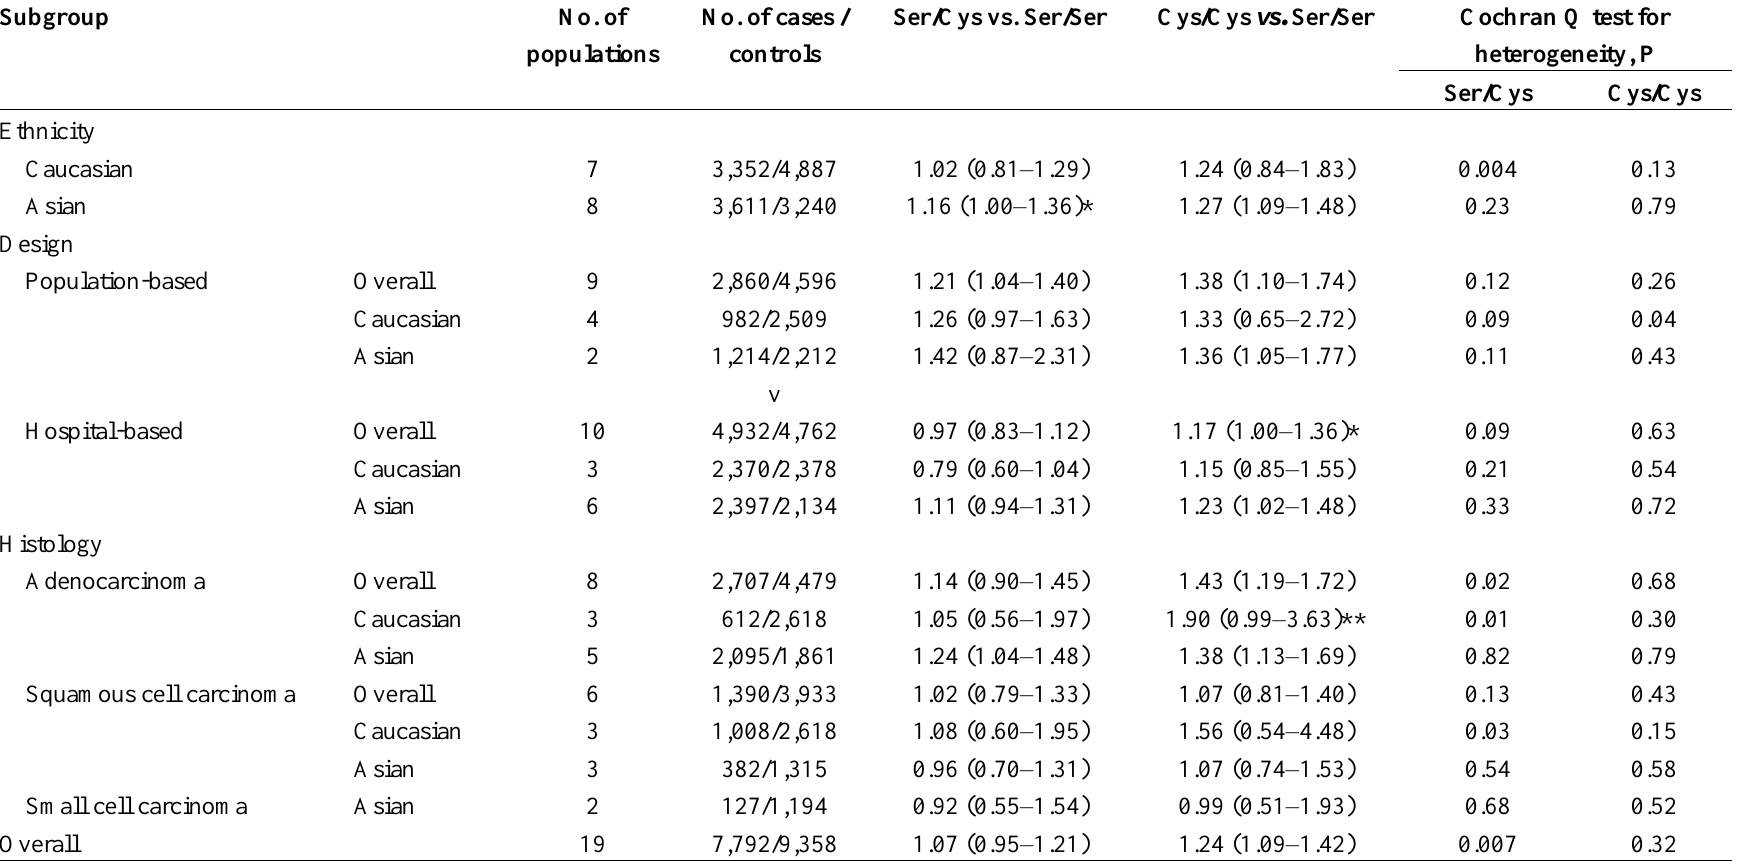
Table 3. Summary of OR for the hOGG 1 Ser326Cys polymorphism and lung